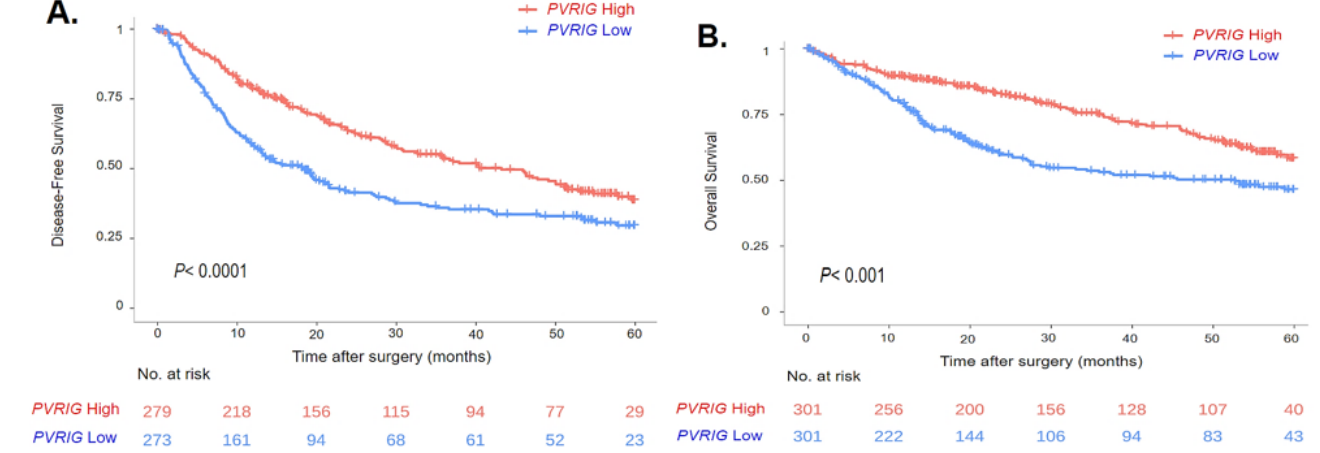
Figure 4. Survival curves in HCC patients based on PVRIG gene expression levels (High vs. Low): ( A ) Kaplan–Meier curve in HCC patients with DFS data (n = 552). ( B ) Kaplan–Meier curve in HCC patients with OS data (n= 602). The p -value indicates the log-rank test. In univariate analysis, in addition to PVRIG Low and High groups ( p = 5.1 × 10 − 5 ), the other variables associated with DFS were the TNM/UICC classification and the HBV infection status ( p = 1.9 × 10 − 3 and p = 1.8 × 10 − 6 , respectively) (Table 3). In multivariate analysis, PVRIG Low and High groups, the TNM/UICC classification, and the HBV infection status remained significant (Table 3). Thus, the PVRIG gene expression level is an independent prognostic factor for DFS in HCC patients (HR = 0.7, range [0.5–0.8], p = 8.5 × 10 − 4 ). Table 3. Univariate and multivariate prognostic analyses for DFS (n = 552). Characteristics